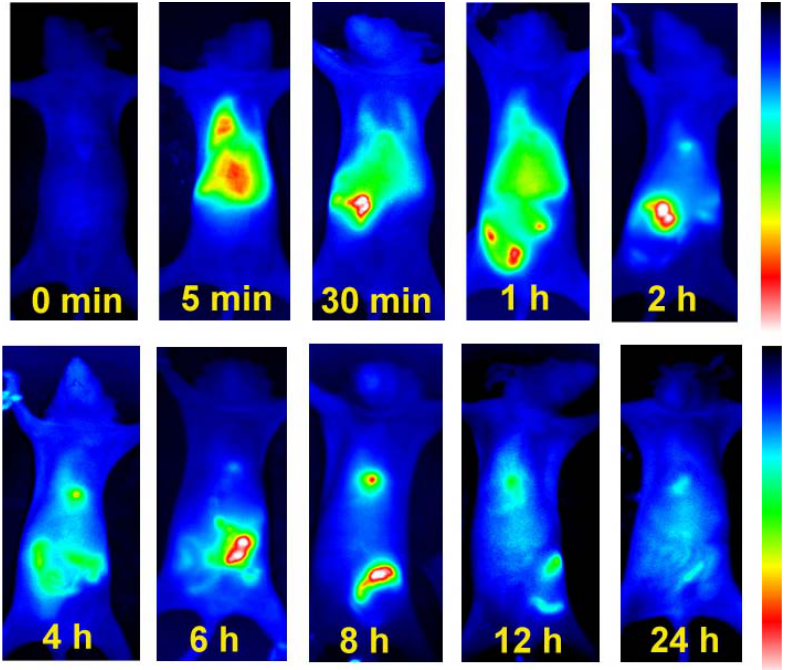
Fig. 4. NIR images of normal nude mice after intravenous injection of RAW 264.7